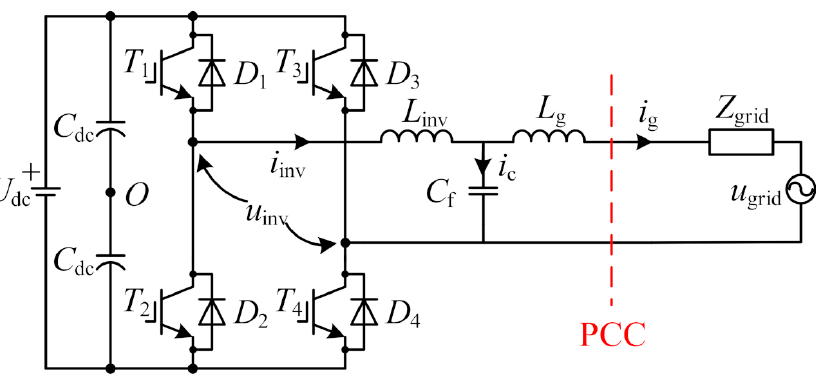
Figure 1. Single-phase voltage source LCL-type grid-connected converter.